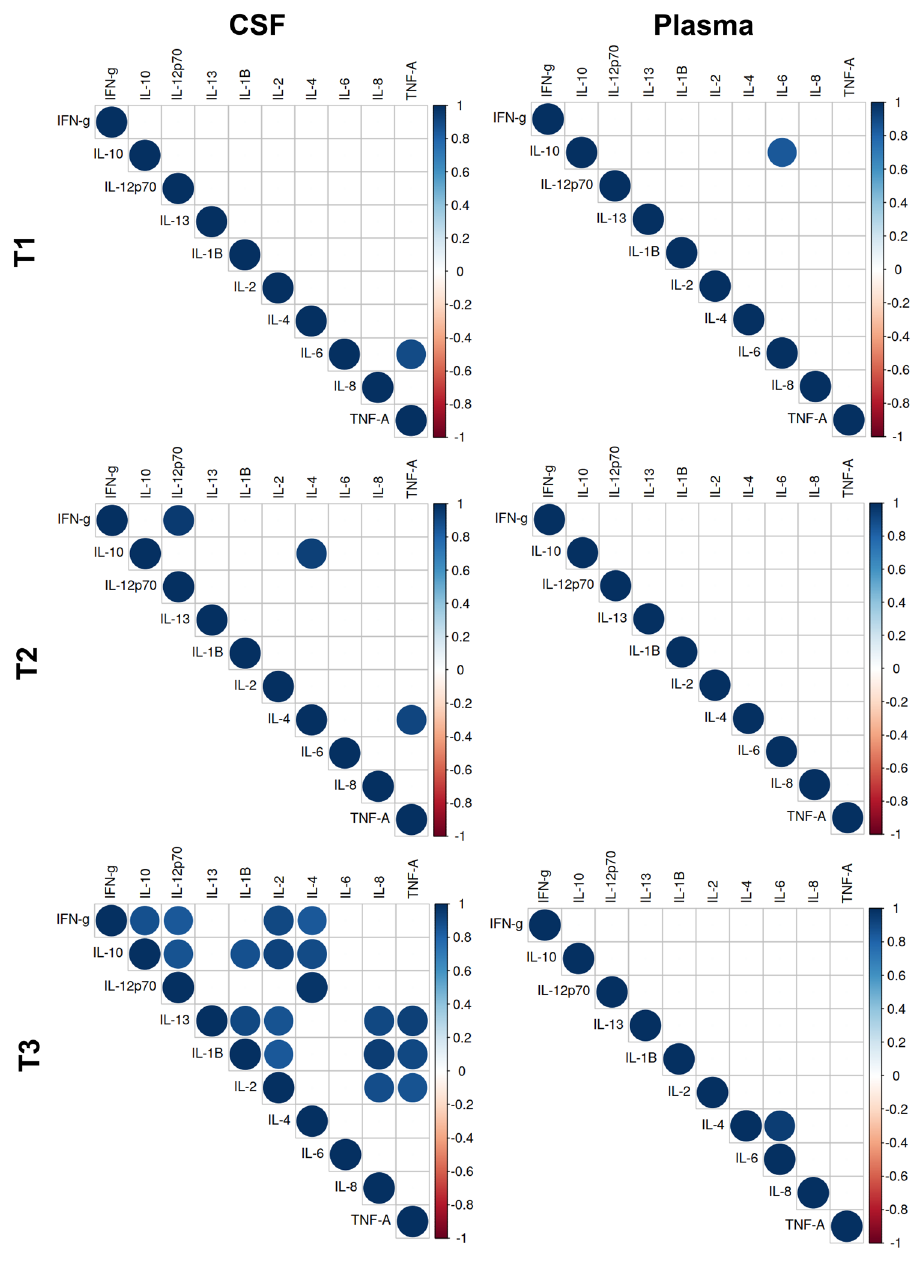
Figure 2. Correlation plots between cytokines at different time points. Correlation plots between cytokines for plasma and cerebrospinal fluid (CSF) before surgery (T1), immediately after surgery (T2) and the day after surgery